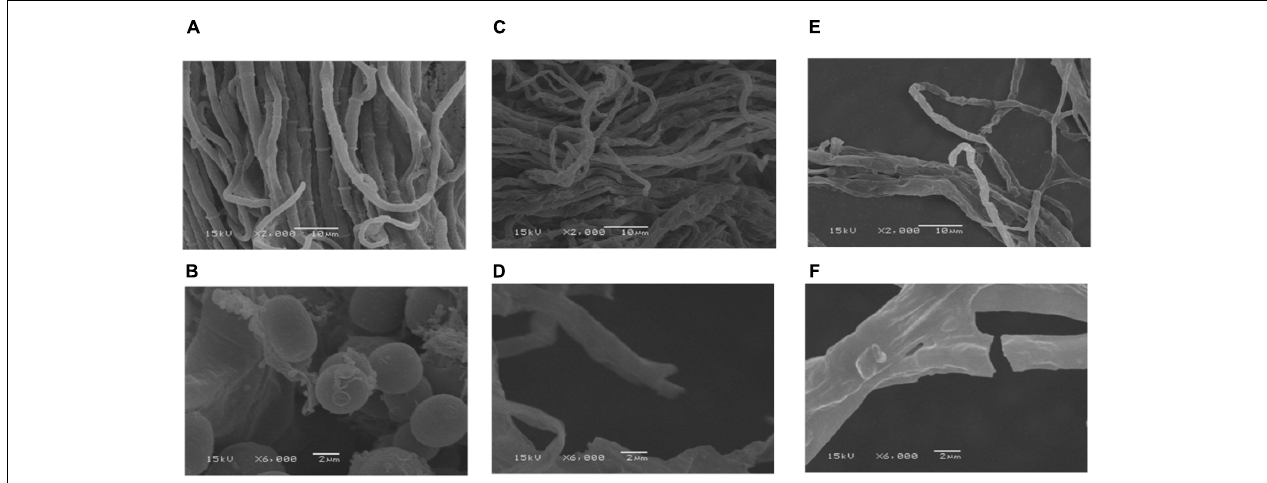
FIGURE 2 | Scanning electron microscopy images with the bars at 2 µ m and 10 µ m of mycelia of P. microspora exposure to 0 (A,B) , EC 50 (C,D) and EC 90 (E,F) of GO.